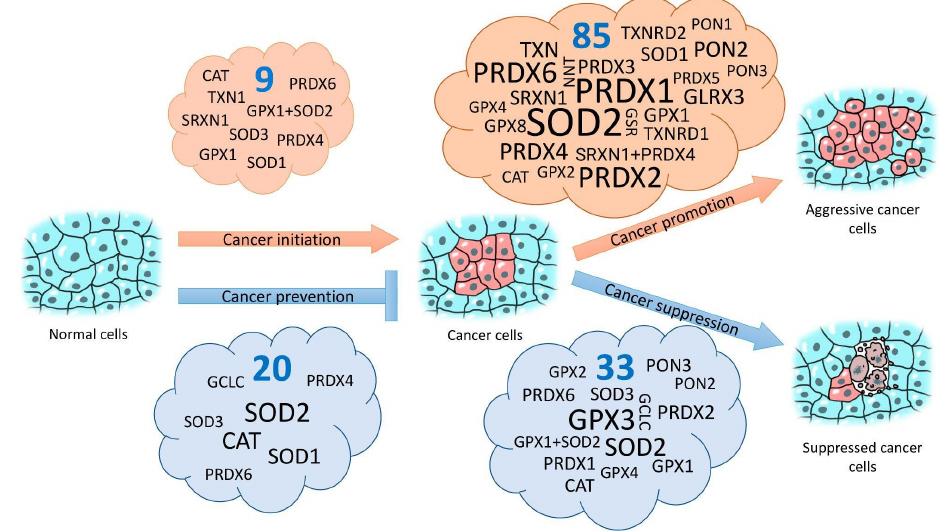
Figure 1. Effects of the overexpression of antioxidant defense genes on the probability of normal cells/tissues malignization and on the aggressiveness of already developed cancer cells/tumors. The font size is proportional to the number of studies that showed the effect of the overexpression of that gene. Numbers in blue show total numbers of studies in each group.